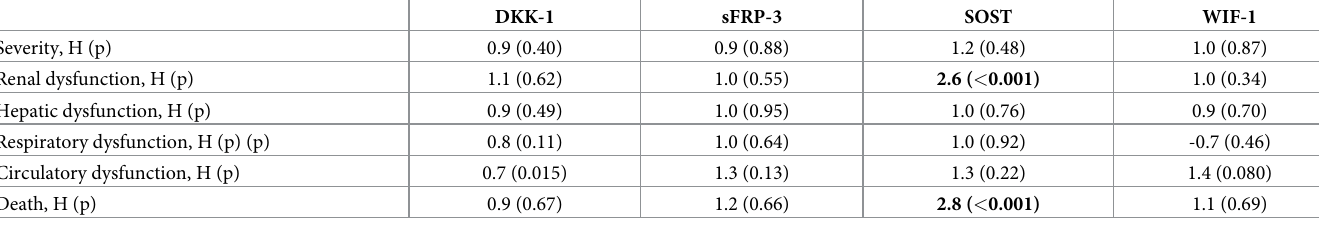
Table 3. Plasma levels of secreted Wnt antagonists in relation to severity and outcome.